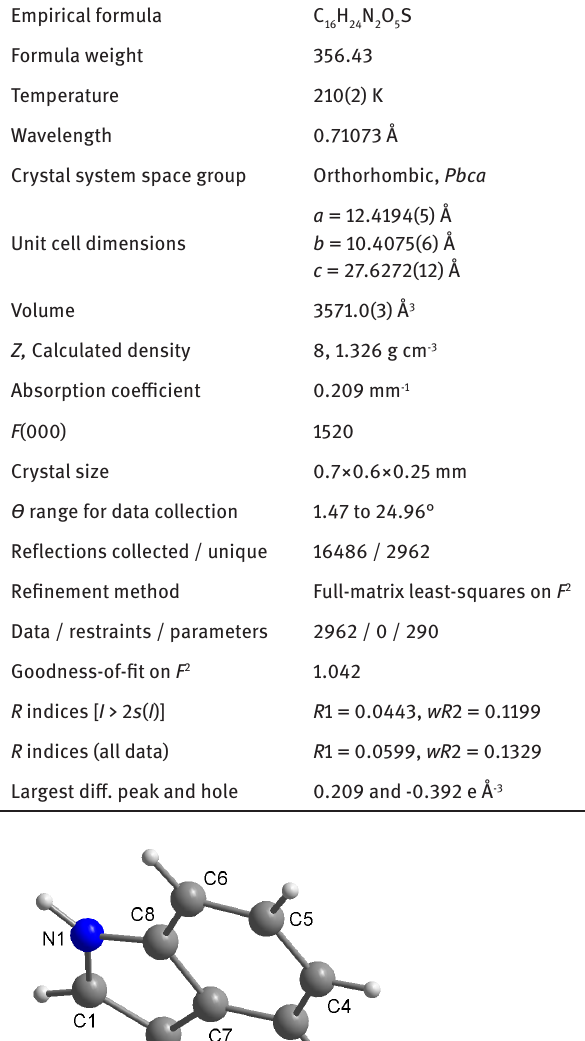
Table 1: Crystal data and details of the structure solution and